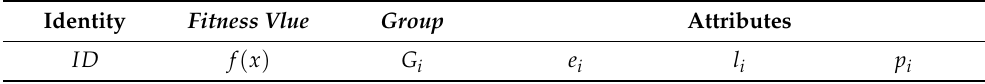
Table 2. Format of the edge